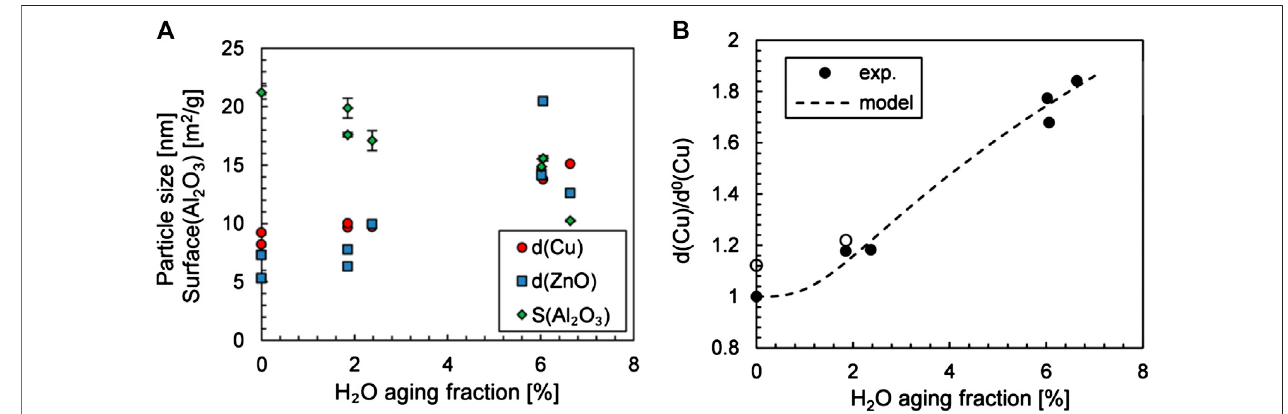
FIGURE 8 | (A) H 2 O impact on the Cu and ZnO particle size and on the Al 2 O 3 surface. (B) Growth factor for Cu(d Cu /d Cu0 ) depending on the molar fraction of the water and model results for 48 h (Pras ̌ nikar et al., 2019). Reproduced with permission from American Chemical